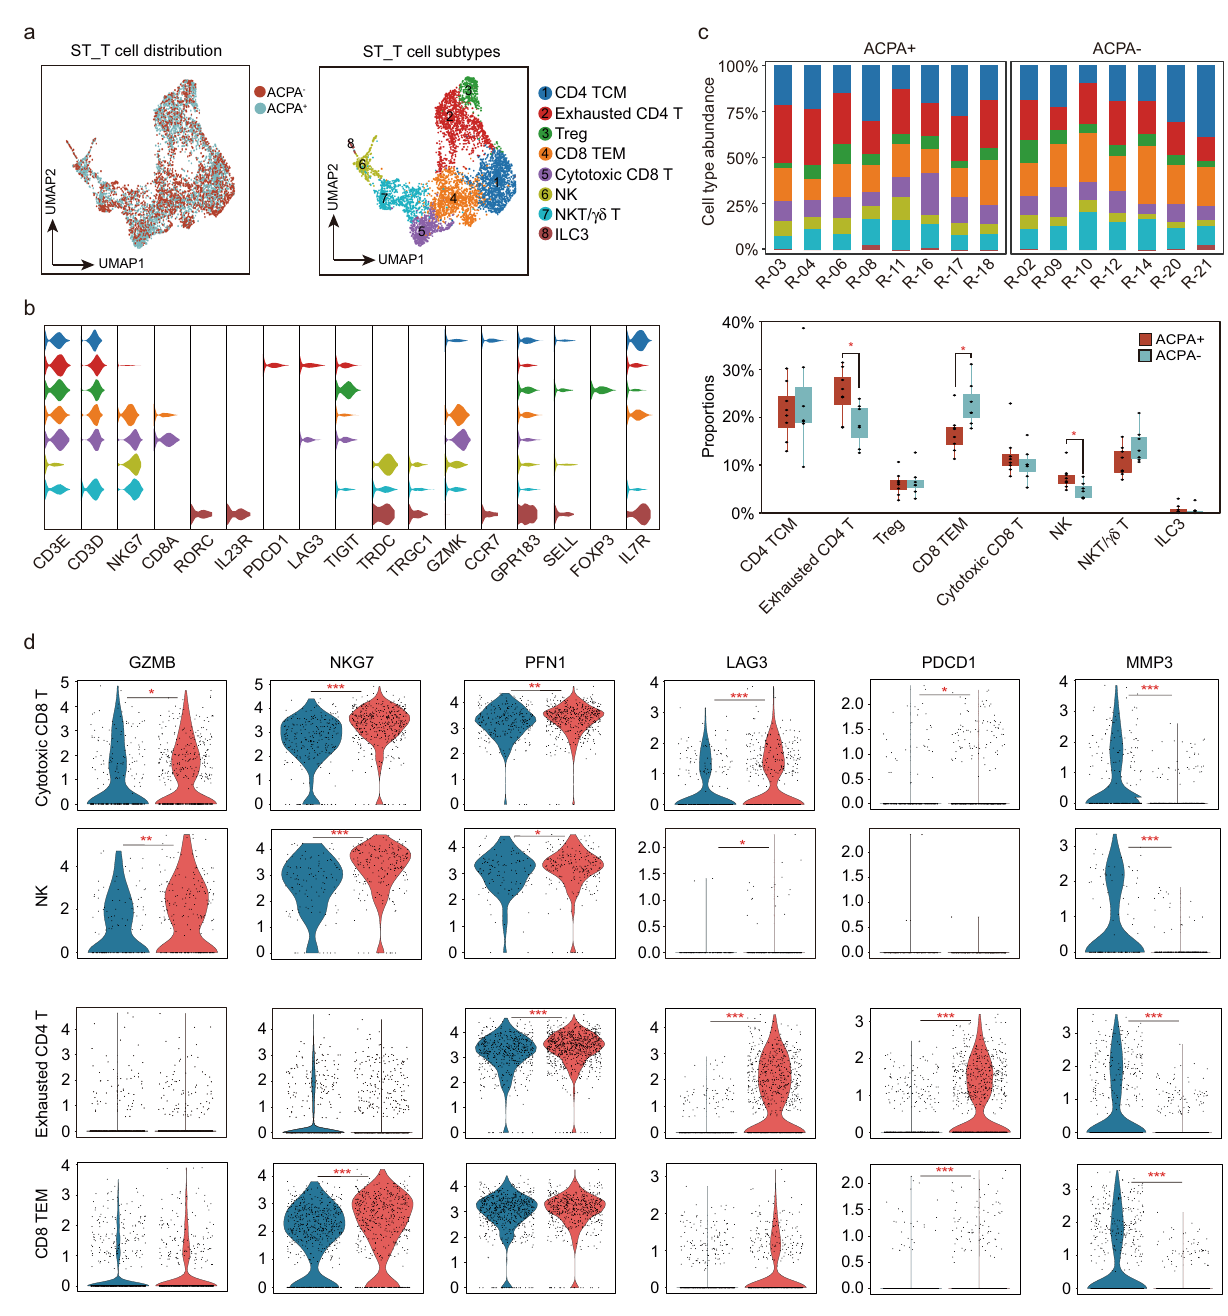
Fig. 9 Identi fi cation of synovial T and NK cell subsets in patients with RA. a UMAP visualization of T/NK cells from STMC, with eight-cell subtypes identi fi ed across 5760 cells. b Violin plots showing marker genes across STMC T/NK cell subtypes in F. The y axis represents log-scaled normalized counts. c Top: bar plots showing the relative percentage of T/NK cell subtypes in STMC for each sample. Bottom: box plots showing the proportions of each T/NK cell subtype in STMC across ACPA groups. Cell types showed enrichment in ACPA + or ACPA- subgroups are marked with *. P values were calculated by the two-side Wilcoxon test. * p < 0.05 (from left to right, p = 0.029, 0.014, 0.021). n = 10 for ACPA + group, and n = 10 for ACPA- group. d Violin plots showing the differences in interested gene expression between ACPA- and ACPA + T/NK cell subtypes in STMC. Asterisks indicate the signi fi cance. P values were calculated by the two-sided Wilcoxon test. * p < 0.05, ** p < 0.01, *** p <